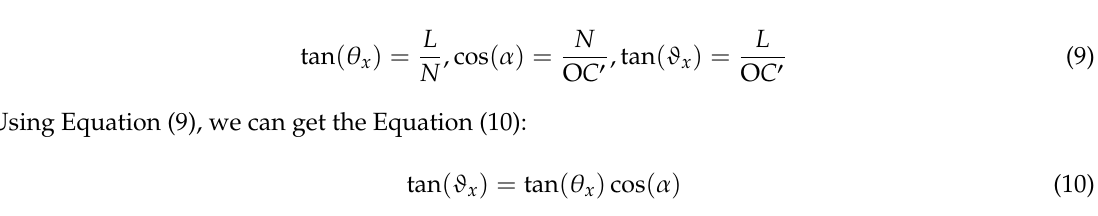
axis Oz is C . The intersection of I y C and the new optical axis is C